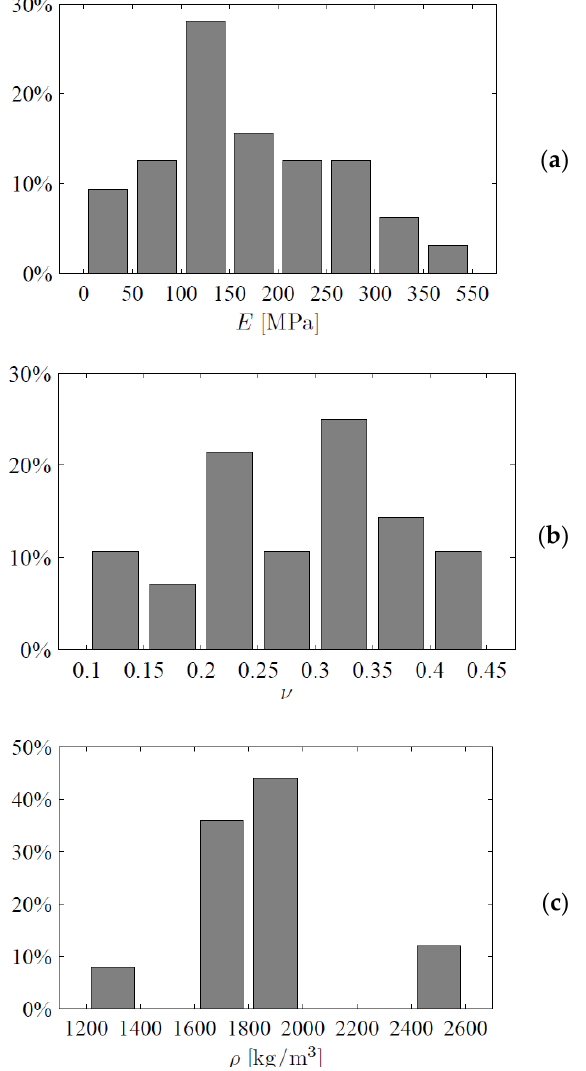
Figure 4. Summary of ballast properties over the literature: ( a ) Young’s modulus, ( b ) Poisson’s ratio , ( c ) density. ( c )